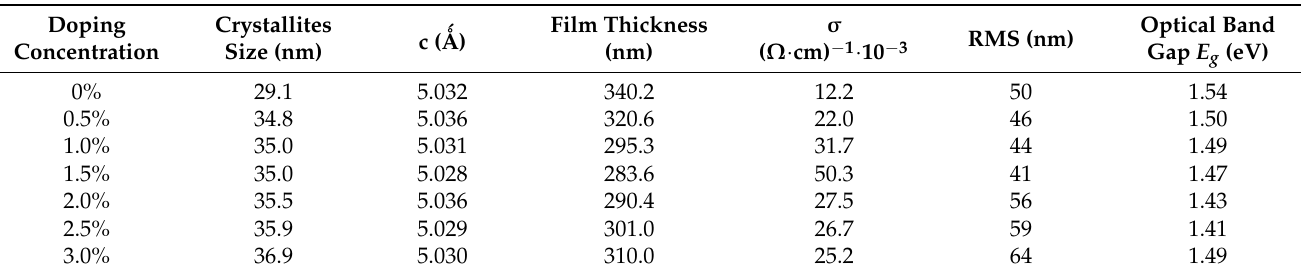
Table 2. The crystallite size ( D ), the lattice parameter c, the conductivity ( σ ), the thickness ( e ), the root mean square (RMS), and the band gap ( Eg ) of CuO thin films with 10 layers at various doping concentrations.